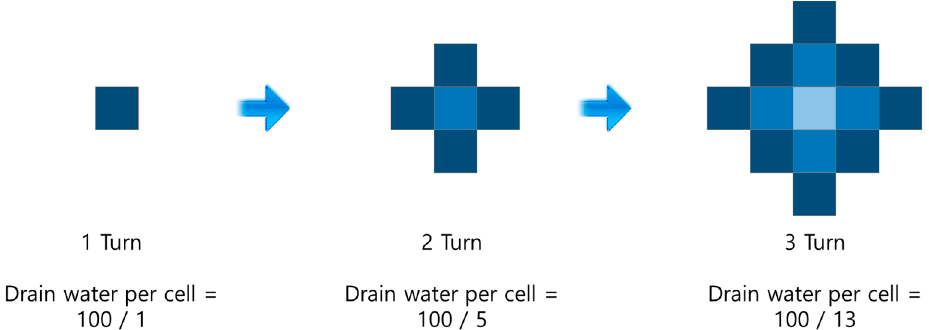
Figure 4. The water sink grid model.